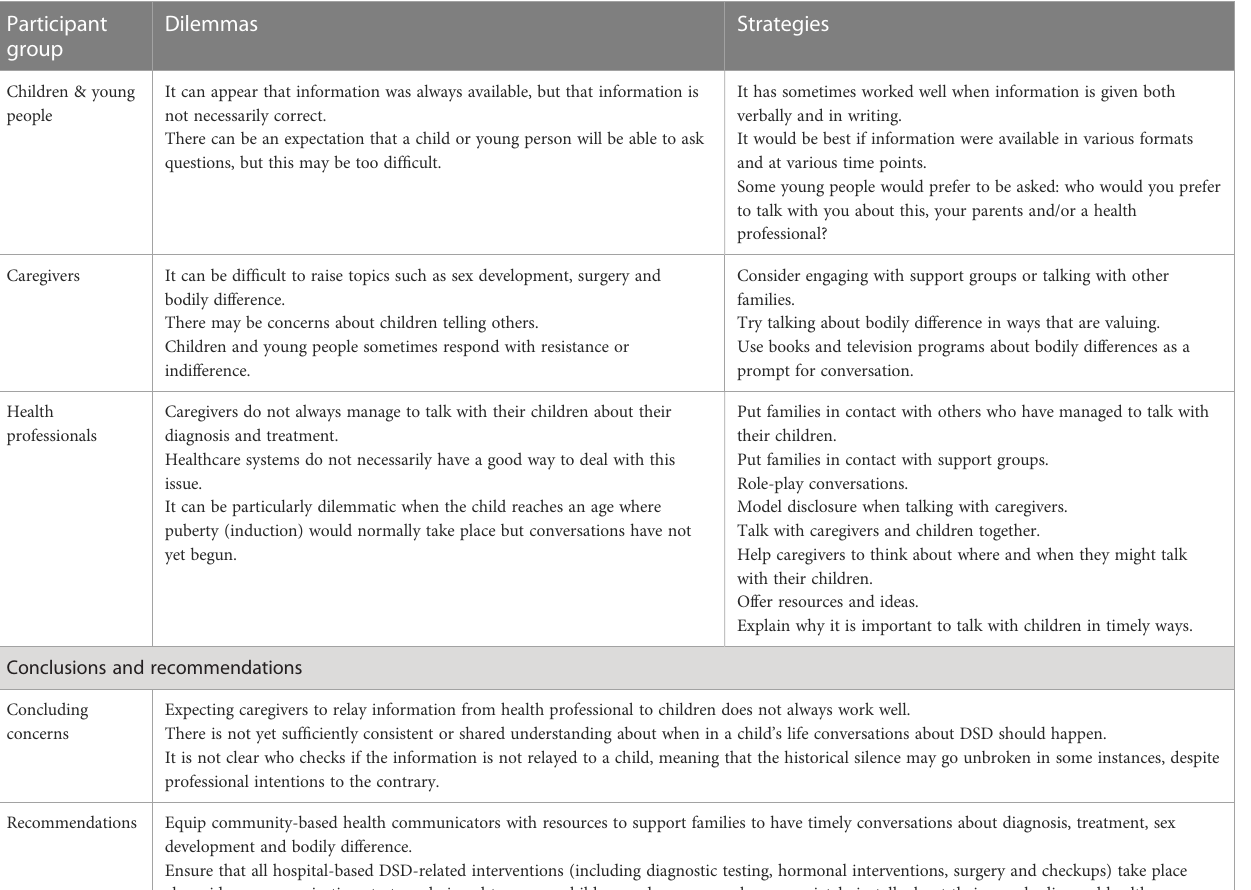
TABLE 2 Analytic points and recommendations.